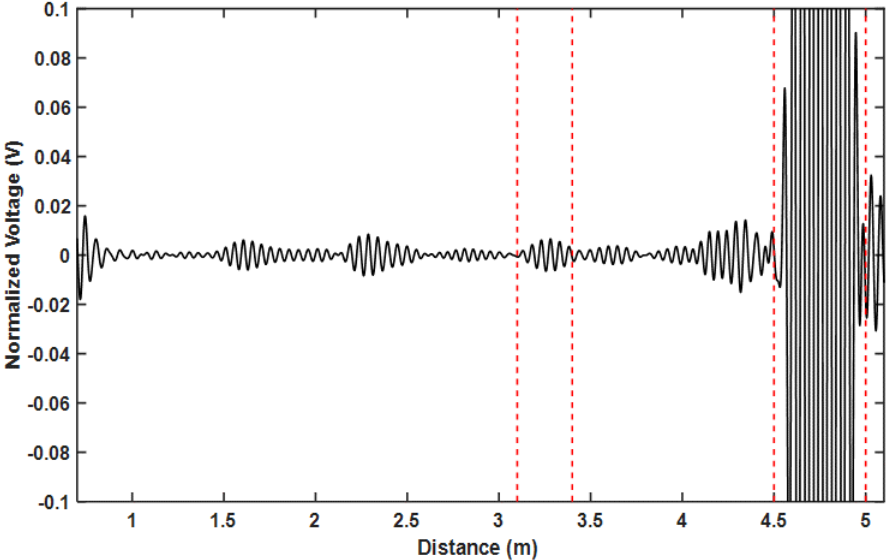
Figure 6. Example signal achieved using general routine, tested by 34 kHz where the first two red dotted lines shows the defect region, and the third and fourth ones show the pipe end.